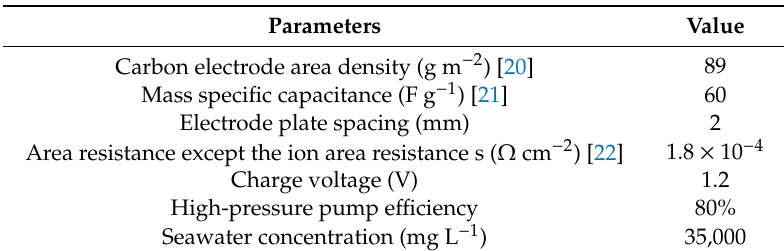
Table 1. Parameter